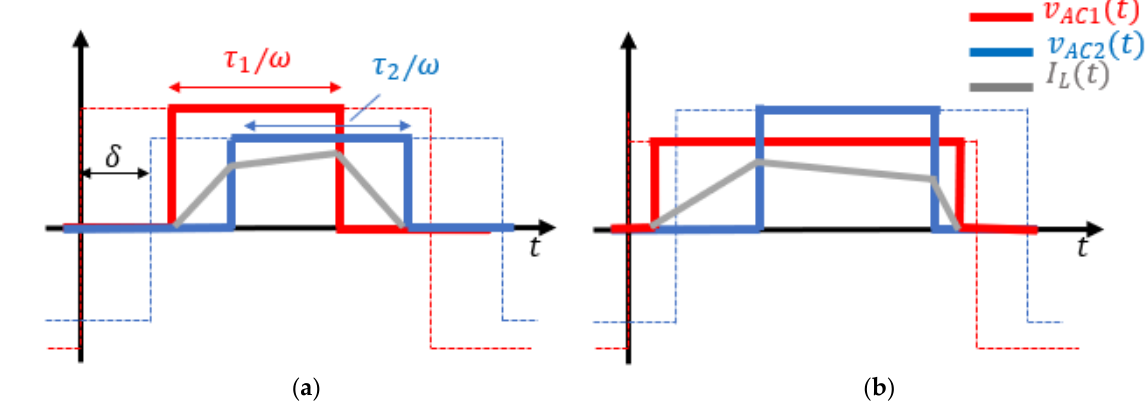
Figure 5. Voltage and current waveforms of half period for trapezoidal modulation ( a ) buck mode, ( b ) boost mode.